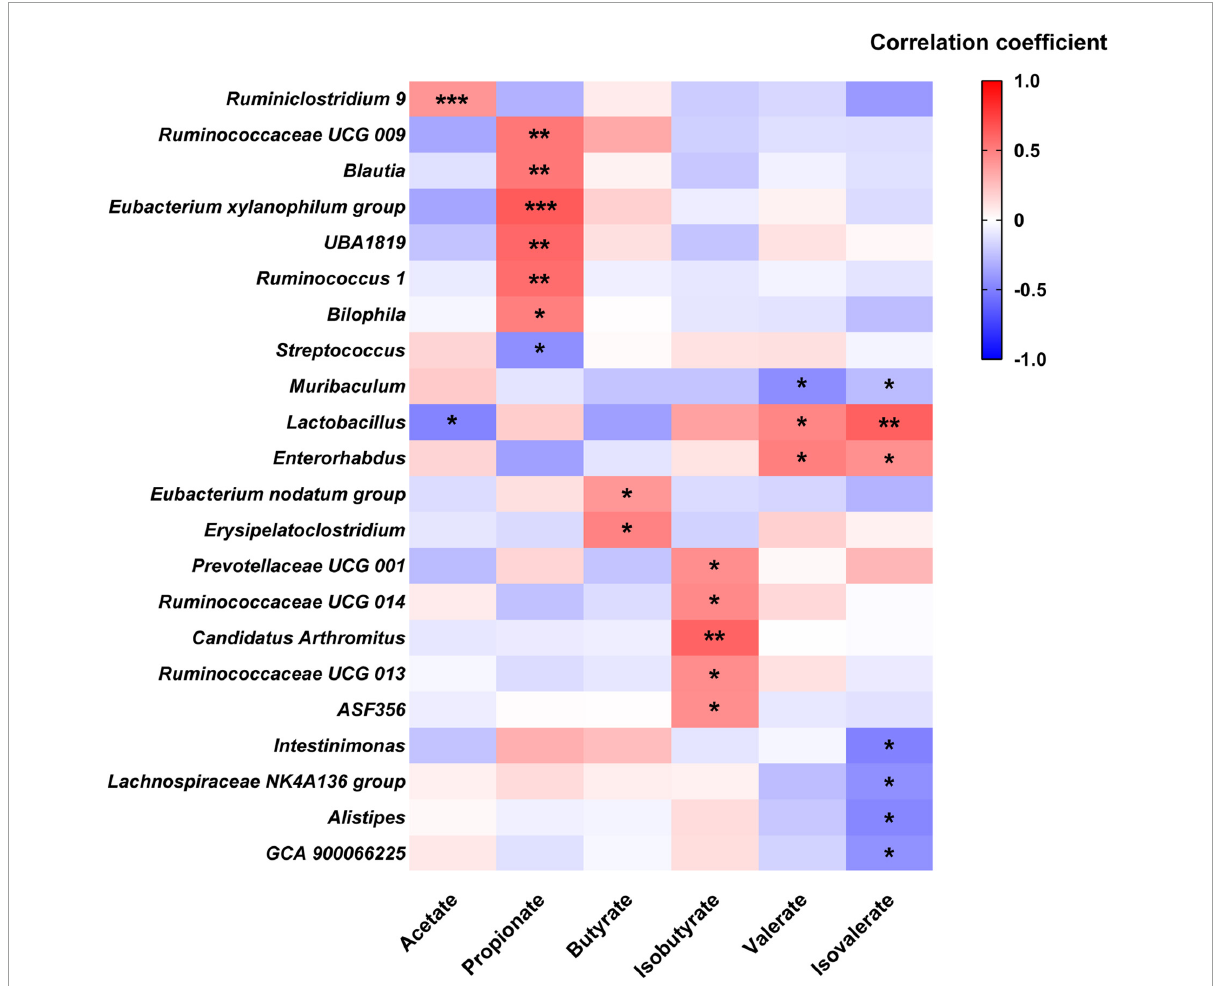
FIGURE6 Heatmap of Pearson’s correlation analysis between SCFA and fecal microbial genera. * p < 0.05, ** p < 0.01, *** p < 0.001 statistical significance of Pearson’s correlation